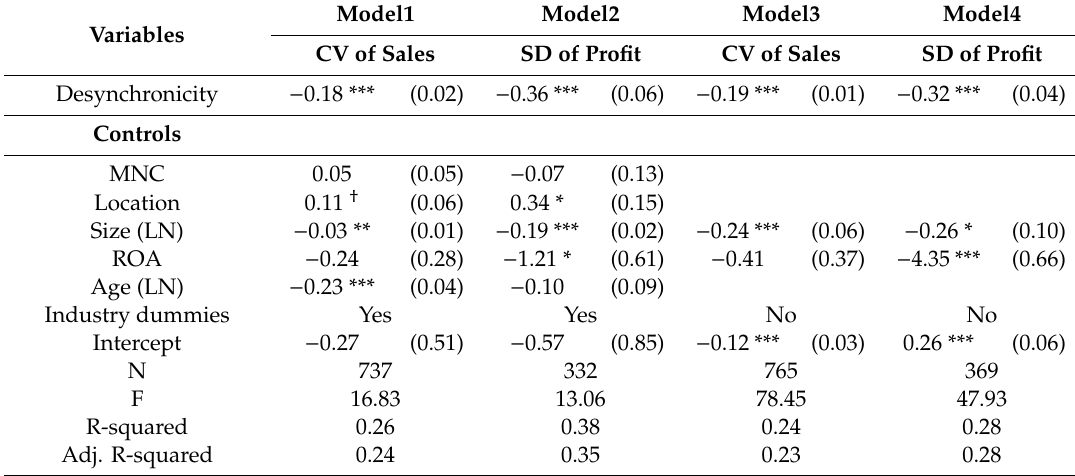
Table 7. E ff ect of Desynchronicity on Corporate